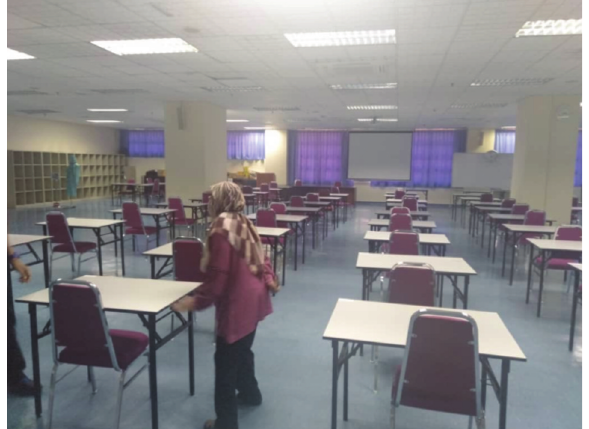
Viva sessions conducted in ward cubicles. Fig. 2: